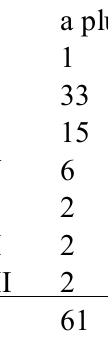
Tabulation C—Modified Model (assuming half all “c” categories are impact) See